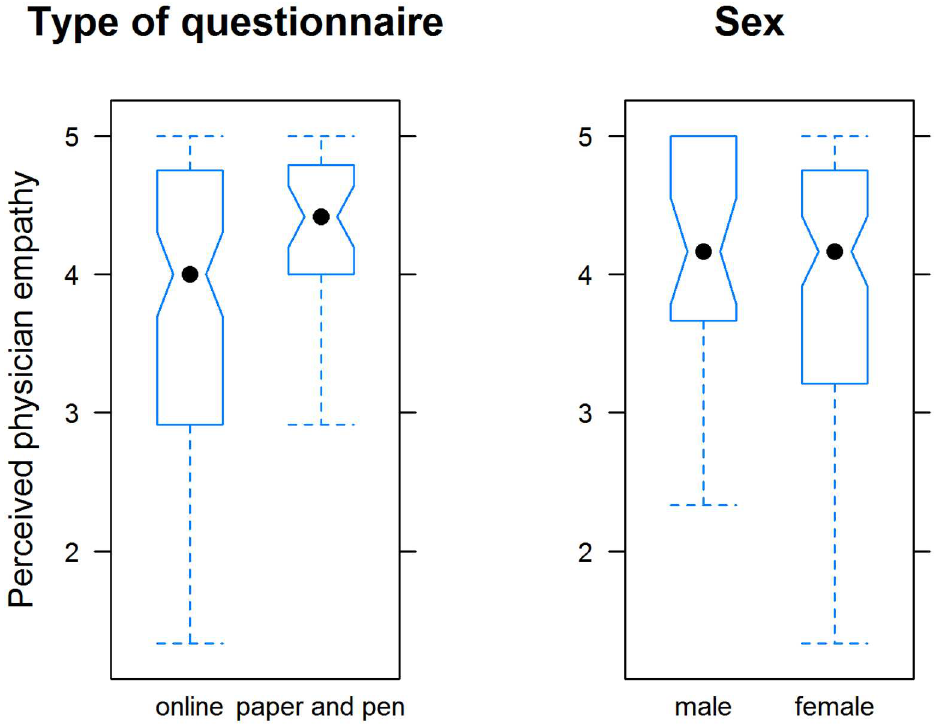
Fig 1. Perceived physician empathy as assessedby the Consultation and Relational Empathy (CARE) measure;Tukey’s box plots. Left: The questionnaire was administered as either an onlineor a paper-and- pen version; the difference was statisticallysignificant (p < 0.001; Mann-Whitney U test). Right: Sex of patients; no difference.